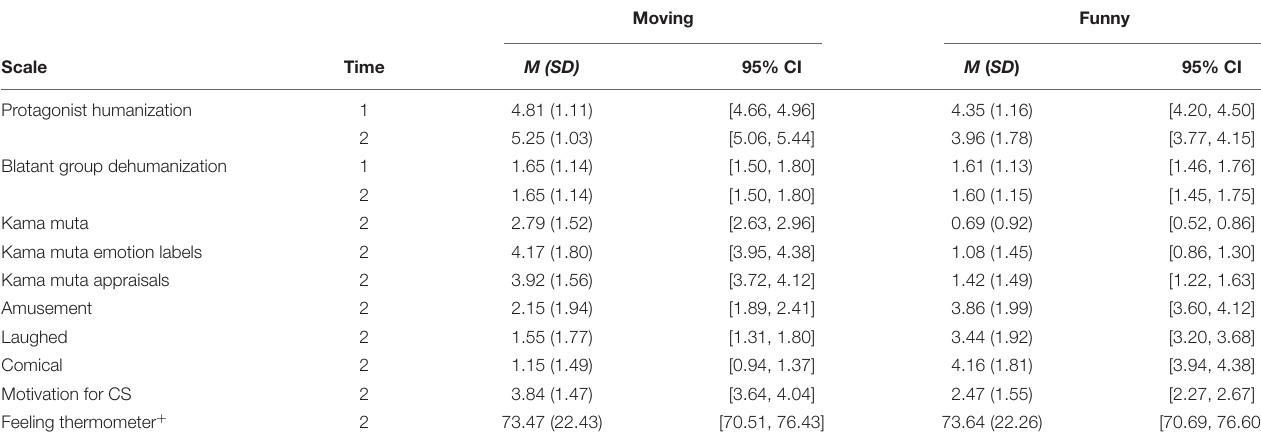
TABLE 2 | Descriptive statistics for measures used in Study 2.